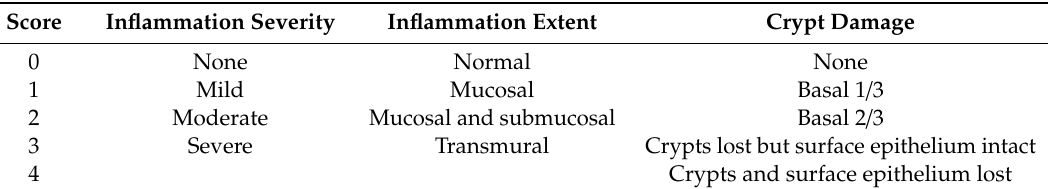
Table 2. Histological scoring of